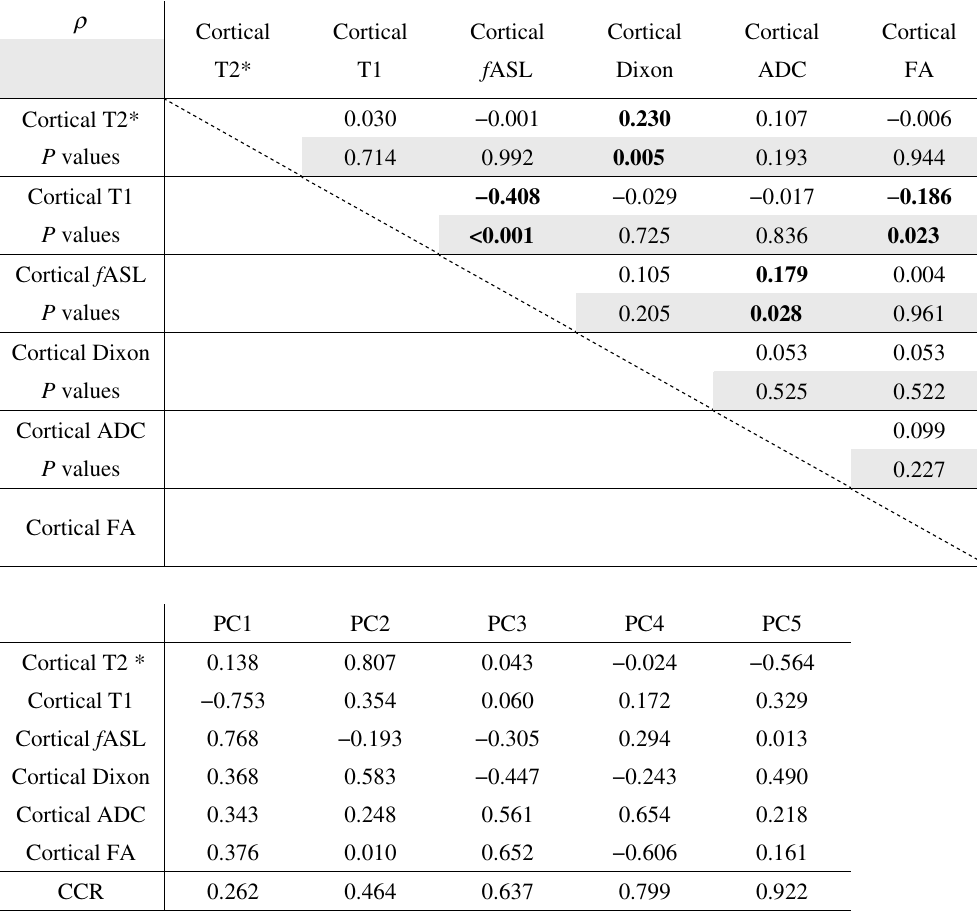
Table 2. Correlation matrix for MRI values and results of principal component analysis. fASL perfusion volume estimated by arterial spin labelling, Dixon signal intensity of Dixon water image, ADC apparent diffusion coefficients, FA fractional anisotropy, CCR Cumulative contribution ratio. P < 0.05 was considered siginficant